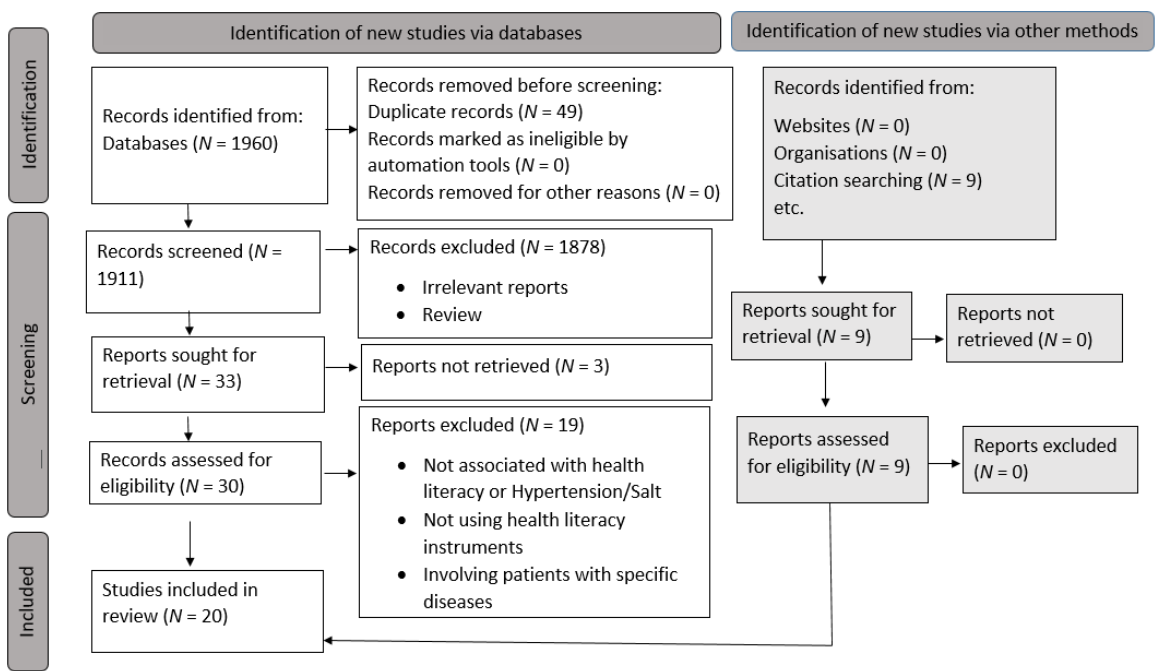
Figure 1. Flow diagram for study selection.